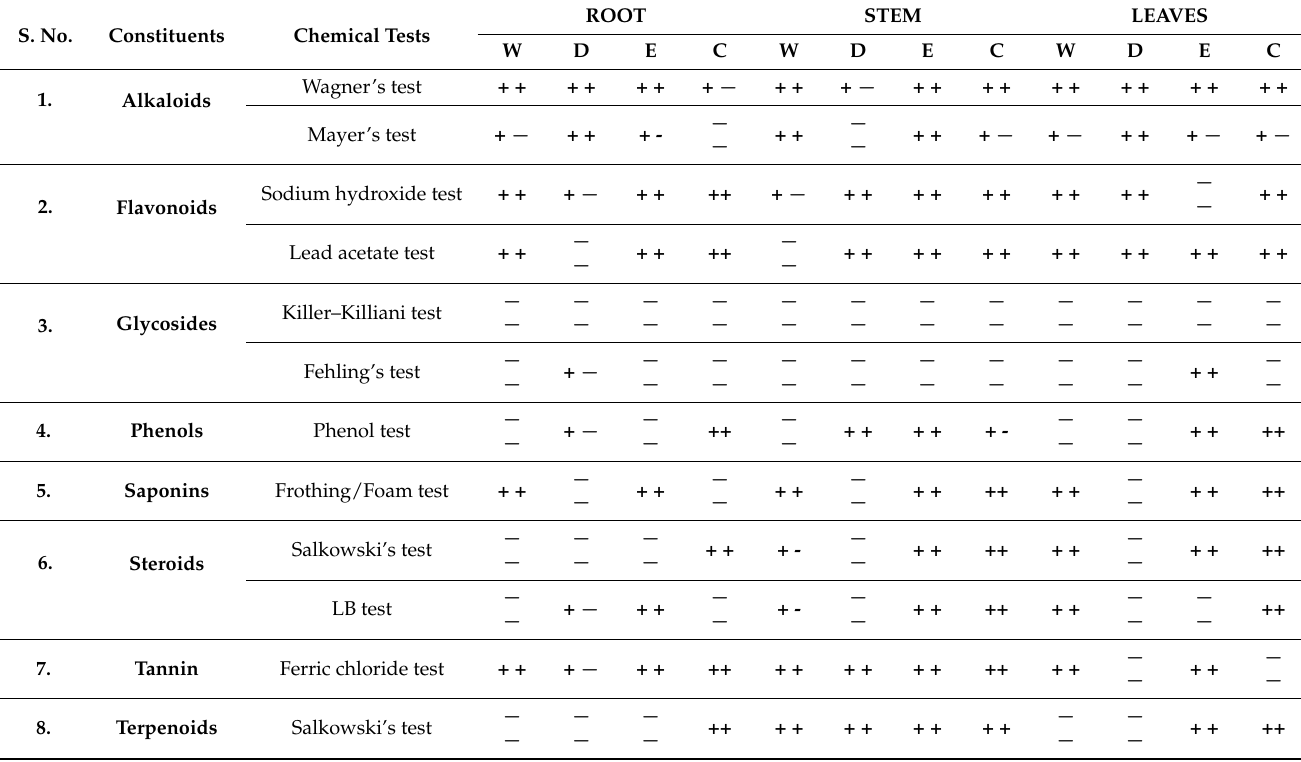
Table 6. Qualitative phytochemical screening of N. triquetra .